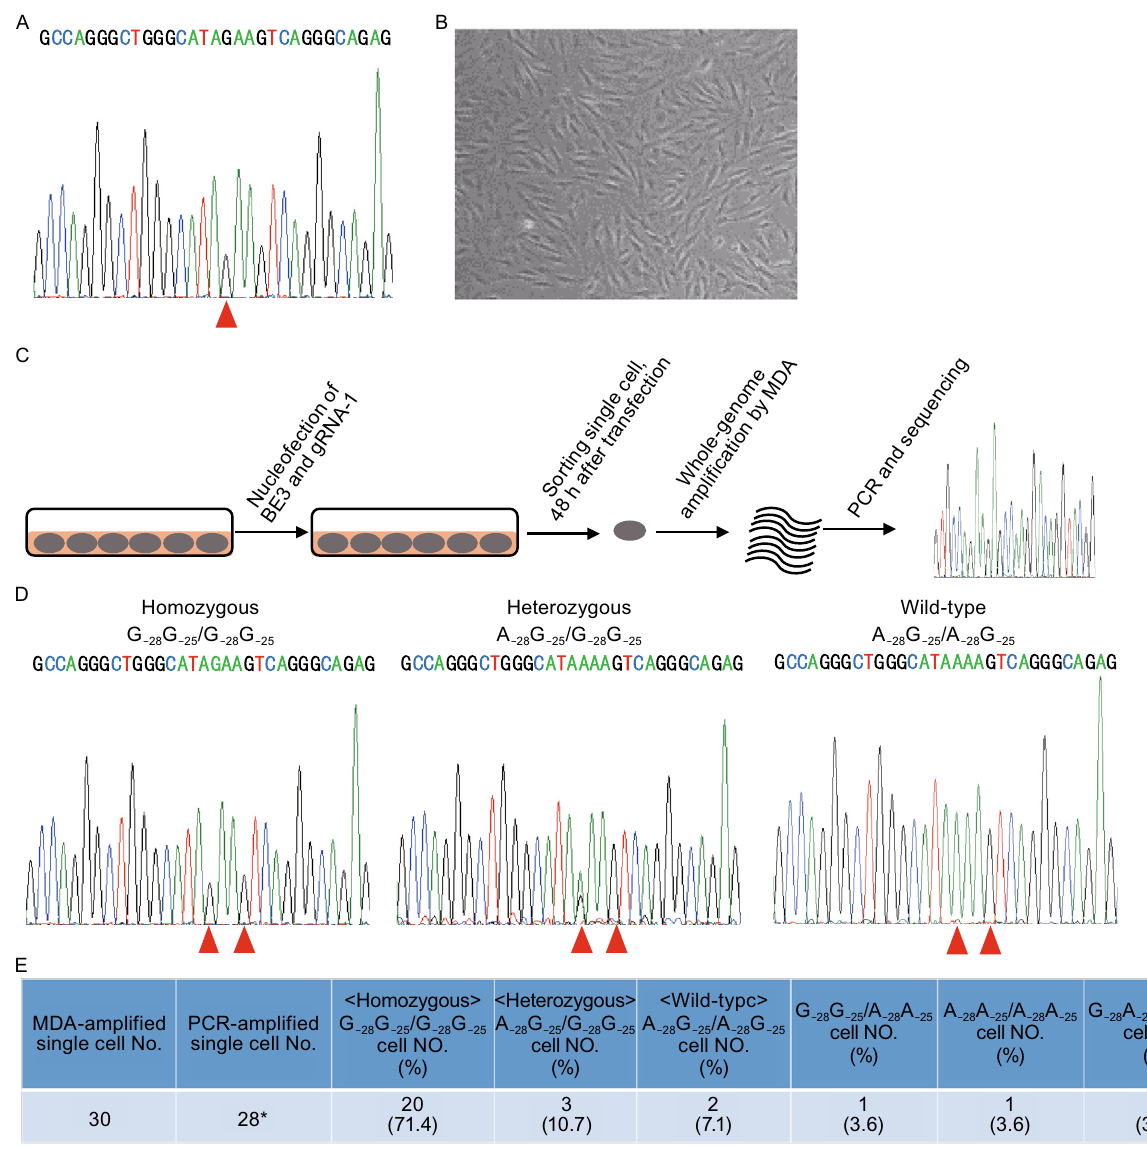
Figure 2. Correcting HBB − 28 (A>G) mutation in primary skin fi broblast cells of beta thalassemia patient. (A) Sanger sequencing to detect the genotype of the patient. Genomic DNA from the patient ’ s cells was extracted for PCR ampli fi cation of the target region. PCR amplicons were then sequenced by Sanger sequencing. HBB − 28 (A>G) mutation were labelled with red arrowhead. (B) Primary skin fi broblast cells from the HBB − 28 (A>G) mutant patient. (C) Schematic of base editing in HBB − 28 (A>G) homozygous mutant skin fi broblast cells and single cell genotyping. Skin fi broblast cells were transfected with BE3 and gRNA-1. 48 h after transfection, single cell was isolated and whole genome ampli fi ed. The genomic DNA was then used as the template for PCR ampli fi cation of HBB site. The PCR product was sequenced by Sanger sequencing. (D) Representative sequencing chromatographs of homozygous mutant cells (G − 28 G − 25 /G − 28 G − 25 ), heterozygous cells (A − 28 G − 25 /G − 28 G − 25 ), and wild-type cells (A − 28 G − 25 /A − 28 G − 25 ). (E) A summary of the base editing ef fi ciency in homozygous skin fi broblast cells from the patient. A total of 30 single cells were whole- genome ampli fi ed. And 28/30 cells were successfully ampli fi ed by PCR. Both G − 28 and G − 25 were converted to A (A − 28 and A − 25 respectively). *PCR ampli fi cation failed in 2